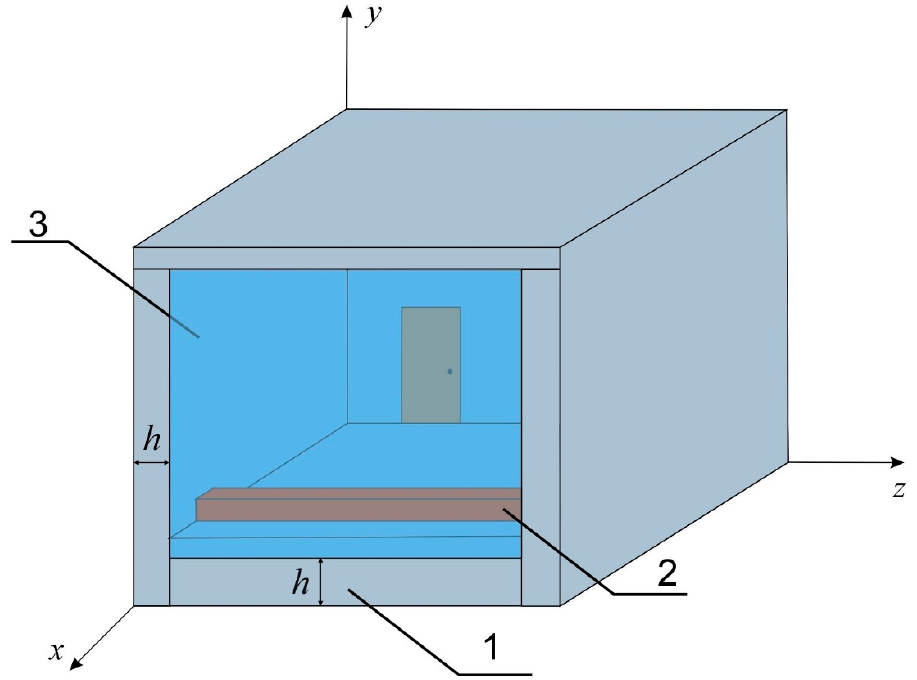
Figure 1. The system configuration: 1—solid walls, 2—heat-generating source, 3—glass wall.